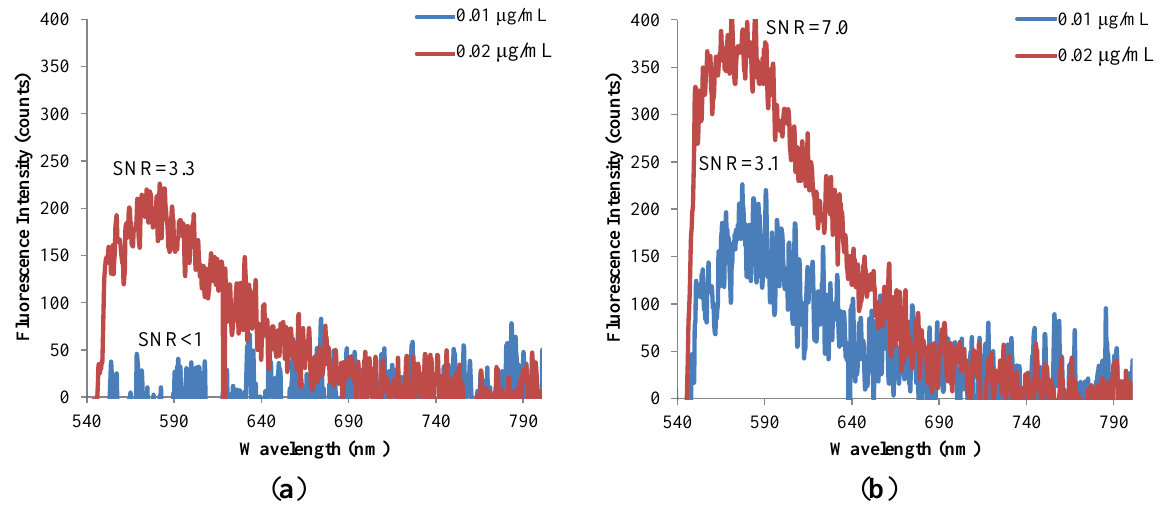
Figure 10. The detection limits of Rhodamine 6G ( a ) without lens and ( b ) with hybrid